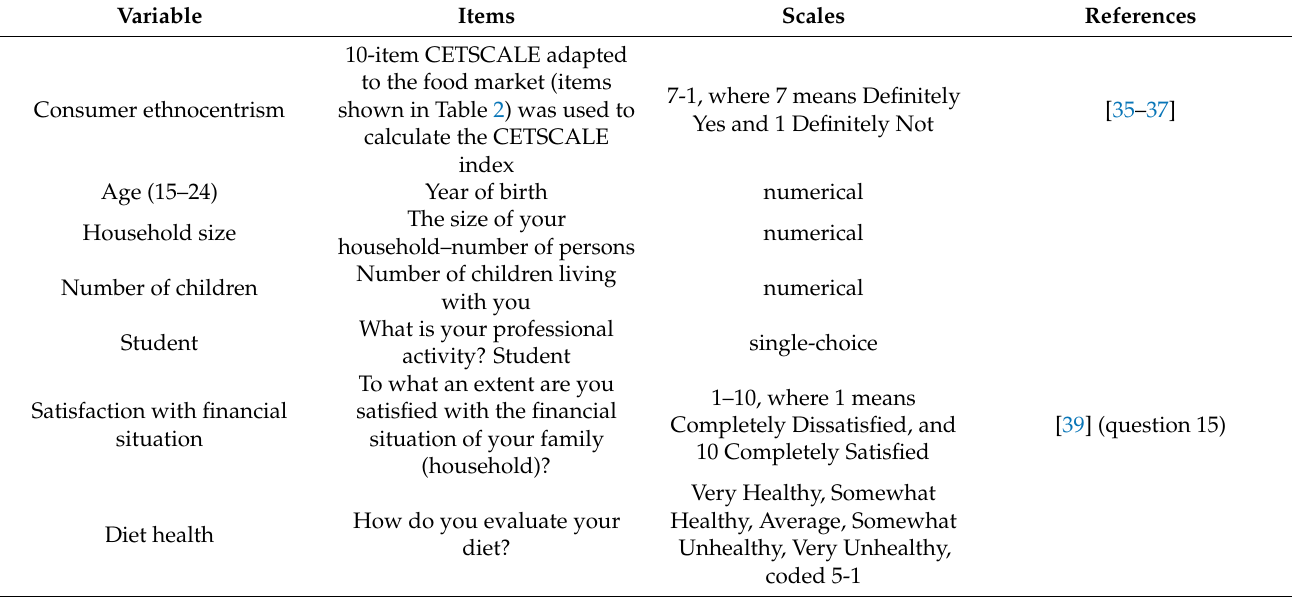
Table A1. Operationalization of variables used in the regression